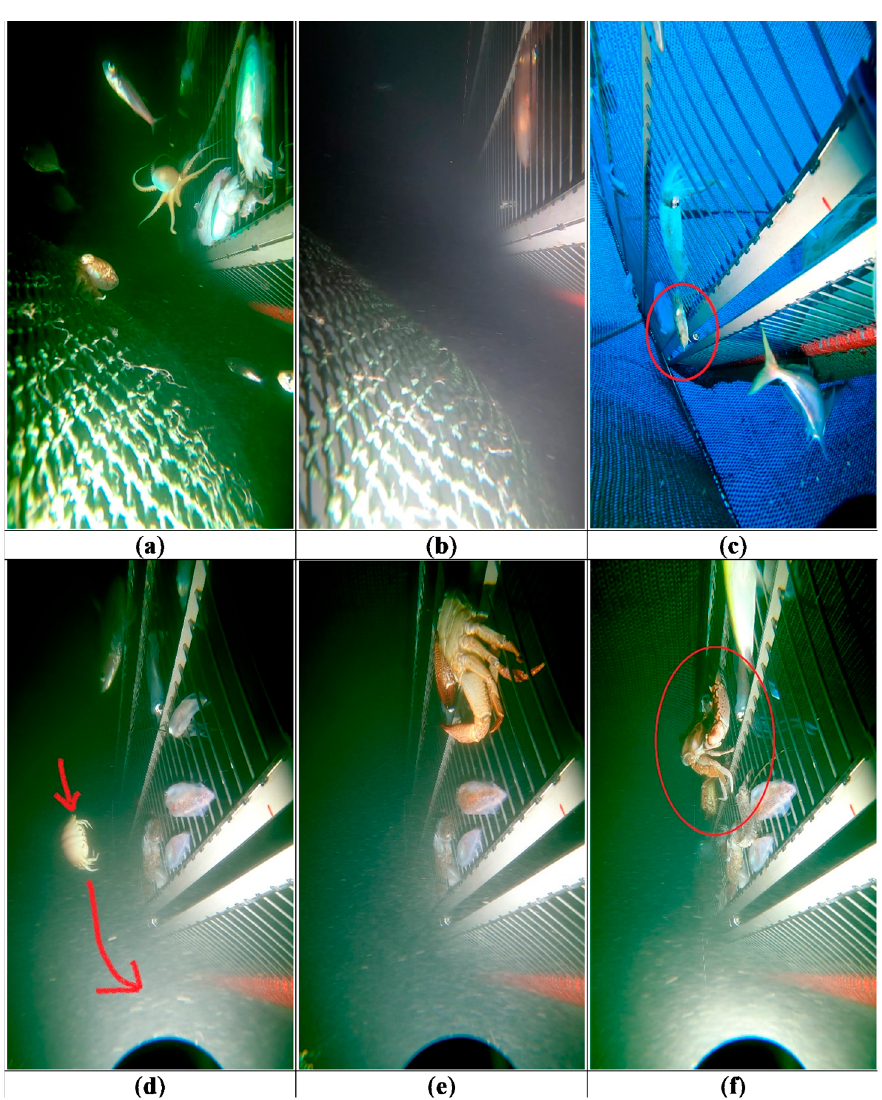
Figure 9. ( a – f ) Underwater photography footage of cephalopods and